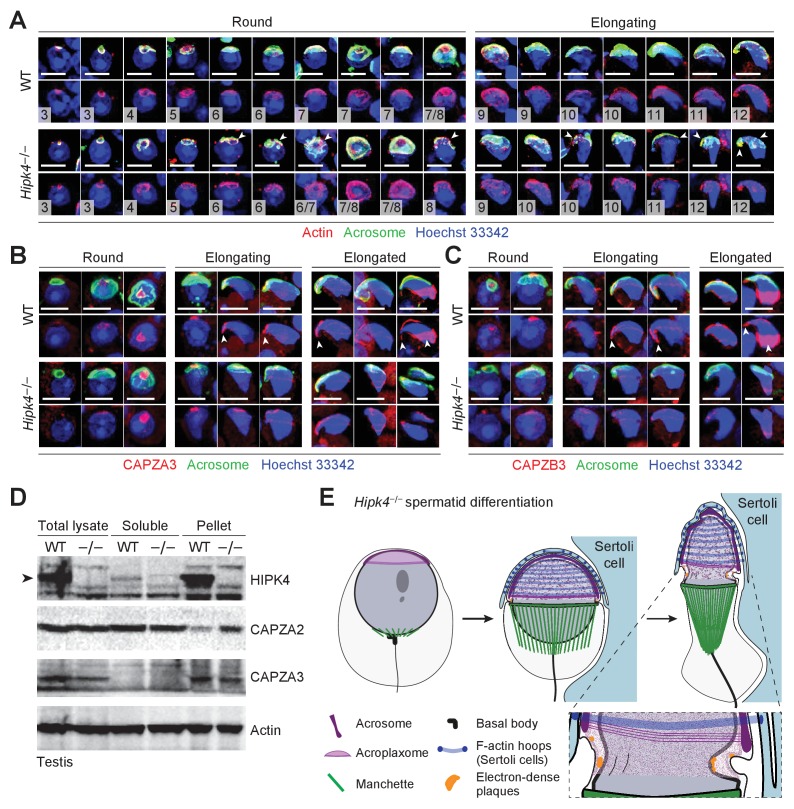
Loss of HIPK4 function alters actin dynamics in the acroplaxome.(A–C) Fluorescence imaging of enzymatically dissociated spermatids co-labeled with FITC-PNA and (A) anti-bβ actin, (B) anti-CAPZA3, or (C) anti-CAPZB3. Nuclei were stained with Hoeschst 33342. Spermatid steps are numbered in (A), and arrowheads point to fragmented acrosomes. Arrowheads in (B–C) indicate the sharp hooked apical tip of wild-type spermatids that correspond to the perforatorium and postacrosomal sheath regions. (D) Western blot of testis lysates before and after F-actin isolation by ultracentrifugation, demonstrating that HIPK4 co-precipitates with F-actin and that HIPK4 deficiency increases CAPZA2 levels in the F-actin pellet. A representative blot from three biological replicates is shown. (E) A model illustrating that HIPK4 is required to maintain the connection between the acrosome, acroplaxome, and nuclear lamina during spermatid elongation. We hypothesize that loss of HIPK4 reduces the scaffolding function of the acroplaxome, compromising its ability to withstand forces applied by the F-actin hoops of Sertoli cells. Scale bars: A-C, 2 µm.